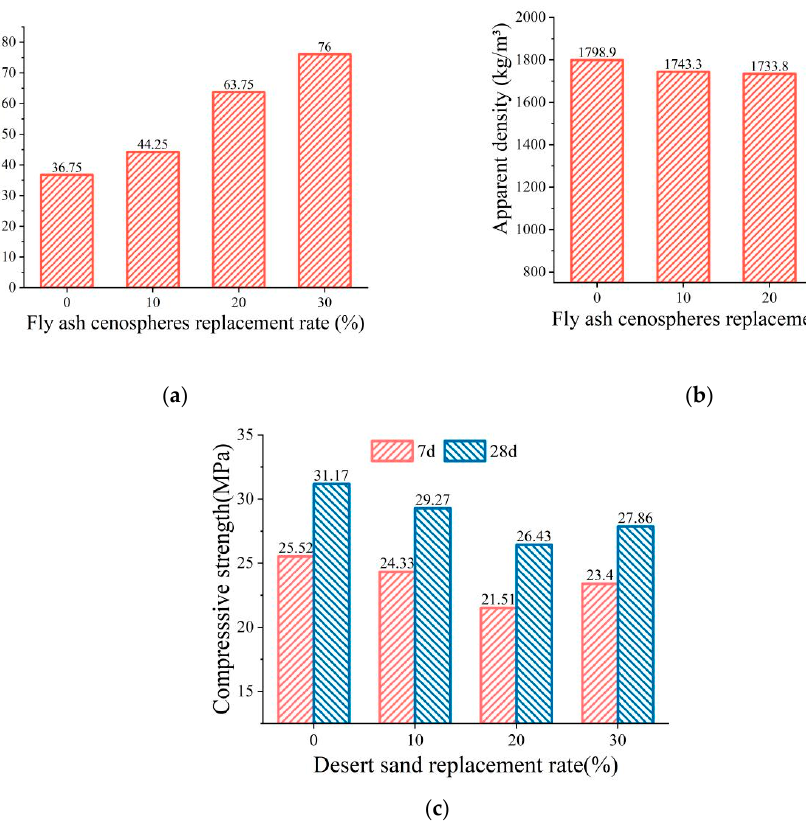
Figure 7. The relationship between the FAC replacing ratio and the FDCC performance: ( a ) slump; ( b ) apparent density; ( c ) compressive strength.